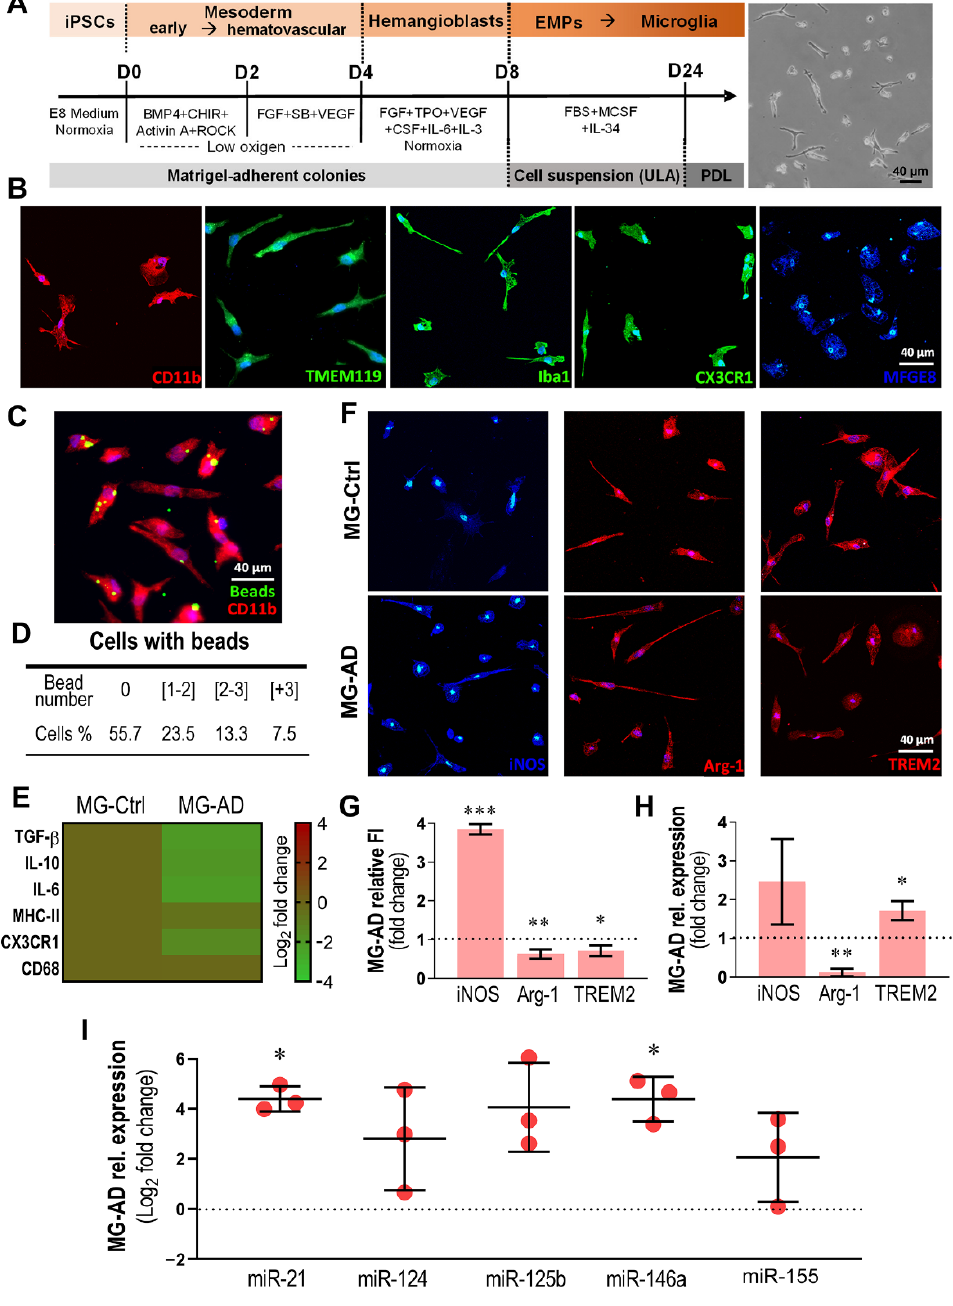
Figure 4. MG-AD cells show increased iNOS, miR-21 and miR-146a, as well as decreased Arg-1 and TREM2, consistent with an inflammatory signature. ( A ) Schematic representation of iPSC differen- tiation into microglia (MG), as detailed in Materials and Methods. ( B ) Characterization of microglial cells for CD11b, TMEM119, Iba1, CX3CR1 and MFGE8 markers. Nuclei were counterstained with Hoechst. ( C ) Representative image of microglia phagocytosing green zymosan fluorescent beads. ( D ) Percentage of cells phagocytosing a distinct number of beads. ( E ) Inflammatory gene heatmap representation (TGF- β, IL -10, IL-6, MHC-II, CX3CR1 and CD68) in MG-AD vs. MG-Ctrl obtained by RT-qPCR. ( F ) Representative images of iNOS, Arg-1 and TREM2 immunofluorescence signal in AD- MG and Ctrl-MG and ( G ) their respective quantification. ( H ) Gene expression data for iNOS, Arg- 1 and TREM2 for MG-AD vs. MG-Ctrl (dotted line), determined by RT-qPCR. ( I ) Quantification of immune-related miRNAs in AD-MG vs. Ctrl-MG (dotted line), shown as the binary logarithm of fold change. All scale bars correspond to 40 µm. Results are mean ± SEM from three independent experiments performed on iPSC-derived microglia from an AD female patient carrying the PSEN1ΔE9 deletion and in a matched control. Two-tailed Student’s t -test: * p < 0.05, ** p < 0.01 and